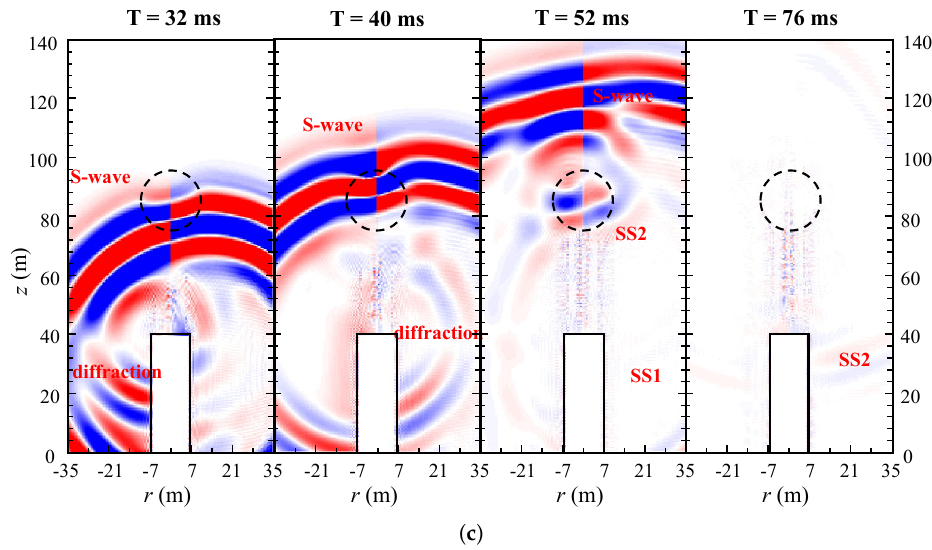
Figure 5. Wavefield of v r component of the karst cave with soft soil at different time. ( a ) 3D wavefield snapshot of the karst cave model filled with soft soil at different times. Planes of ( b ) P -wavefield and ( c ) S -wavefield in ro θ under the karst cave model filled with soft soil at different